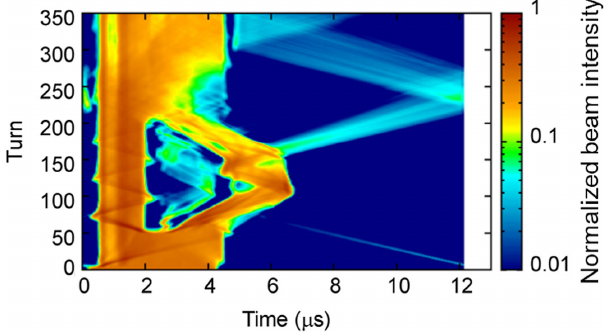
FIG. 7. Evolution of the beam intensity profile in the onDBB